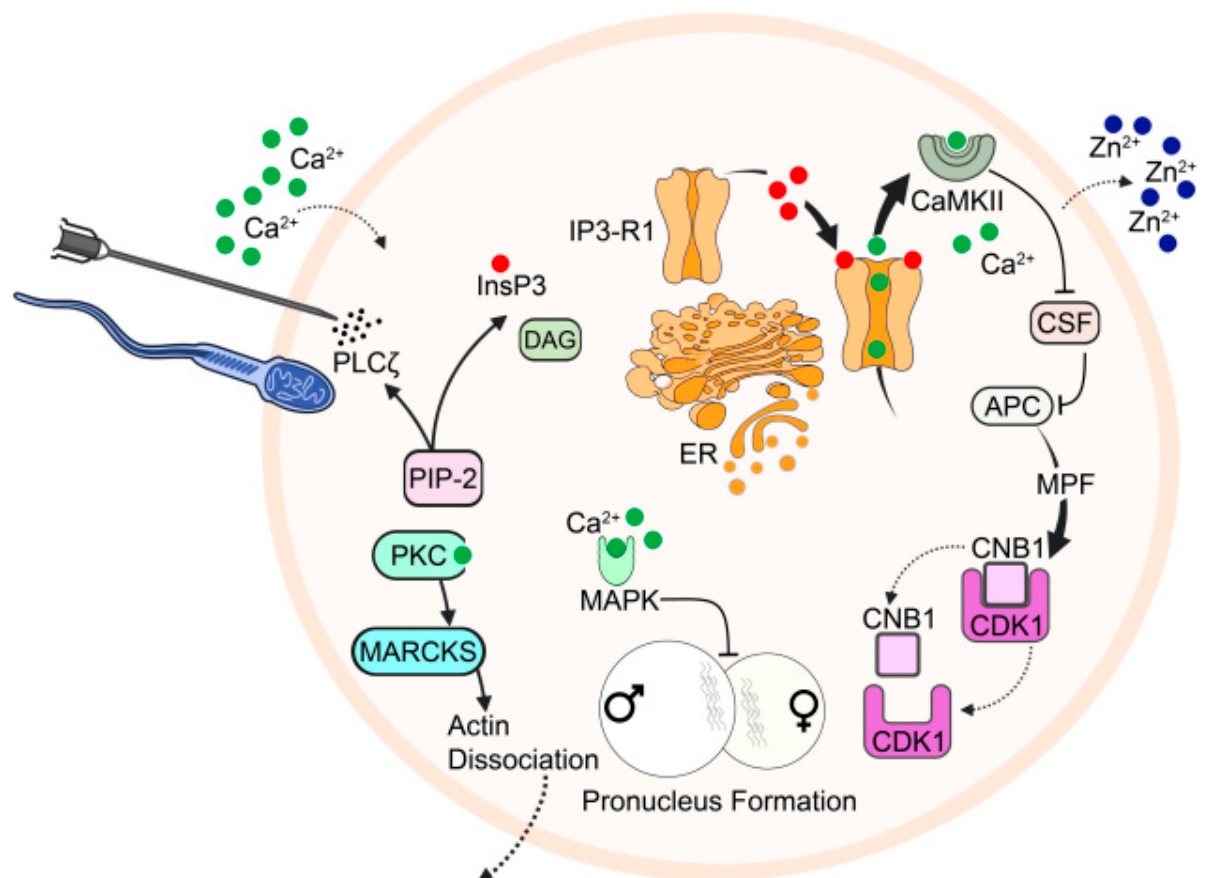
Figure 2. Schematic representation of the mechanistic function of PLC ζ underlying Ca 2+ release at fertilisation, with associated processes resulting from the completion of oocyte activation. The release of PLC ζ from sperm, or even injection into the oocyte, hydrolyses PIP 2 , yielding DAG and IP 3 . IP 3 binds to specific IP 3 R on the ER, triggering Ca 2+ release, and Ca 2+ -induced-Ca 2+ -release (CICR). Released Ca 2+ activates CaMKII, which phosphorylates EMI2 (CSF), releasing APC/C from its usual inhibition that otherwise maintains cell cycle arrest. Ca 2+ release is also linked to the release of Zn 2+ at the Zn 2+ spark, which also down-regulates EMI2 due to a decrease in intracellular Zn 2+ availability. Active APC/C further causes ubiquitination of cyclin B1, resulting in inactivation of MPF, releasing MII arrest. Concurrently, Ca 2+ also activates protein kinase C (PKC), which phosphorylates myristoylated alanine-rich C kinase substrate (MARCKS), which disassociates from F-actin, causing actin breakdown in the oocyte cortex, allowing for cortical granule exocytosis. Ca 2+ release also inactivates mitogen-activated protein kinase (MAPK), leading to pronuclear formation. Figure is an original work, but inspired by [155] .